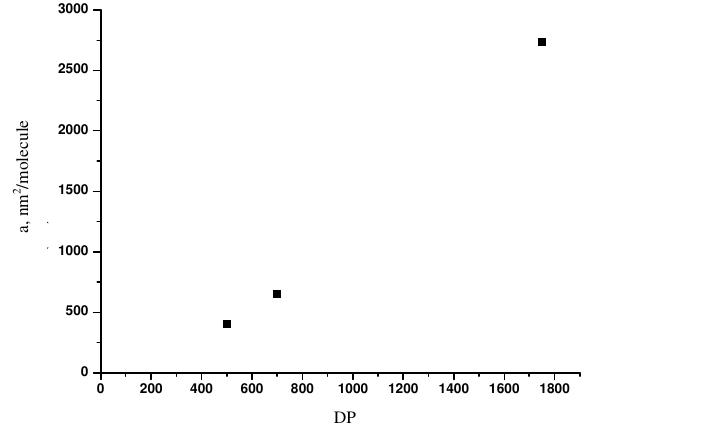
Figure 2. Relationship between PVA, DP and molecule area Table 4. Free energy change of PVA adsorption on EG at 25 o